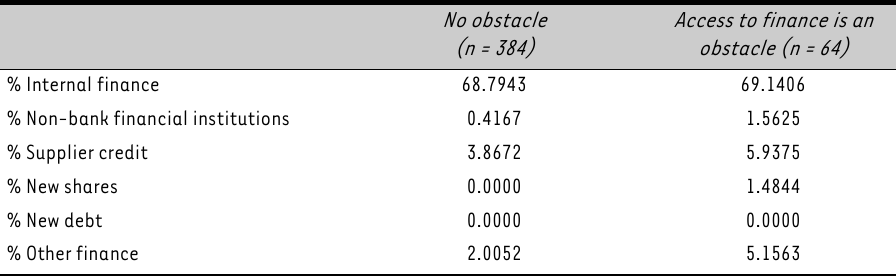
Finance of fixed assets purchases